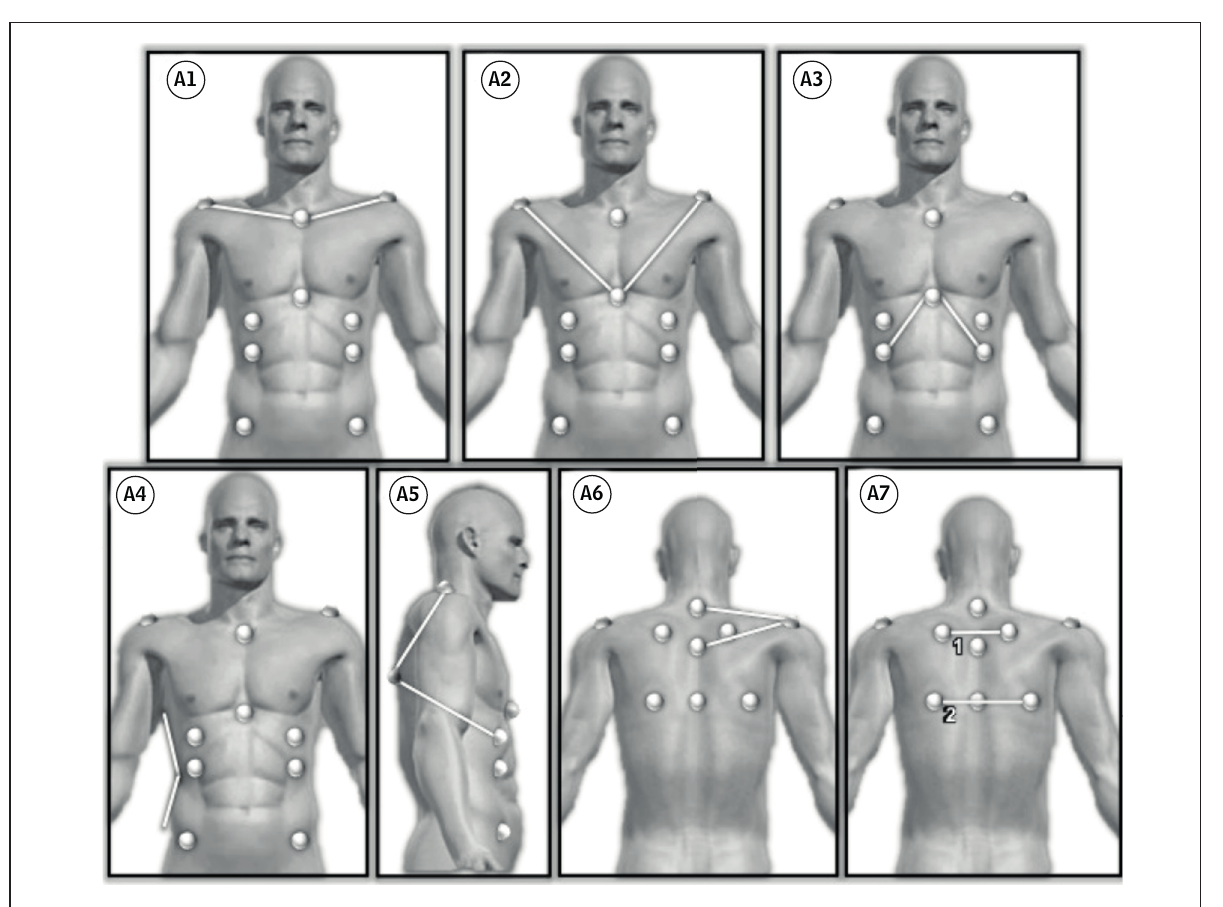
Note: A1 = right acromion/manubrium/left acromion; A2 = right acromion/xiphoid/left acromion; A3 = last false right rib/xiphoid/last false left rib; A4 = angle between the deepest point of the waist and upper and lower edges of the waist; A5 = inframamilar/inferior angle of the scapula/right and left acromion; A6 = C7/acromion right and left/T3; A7 = angle formed by the intersection of the tangent segments of the upper and lower scapulae angles.